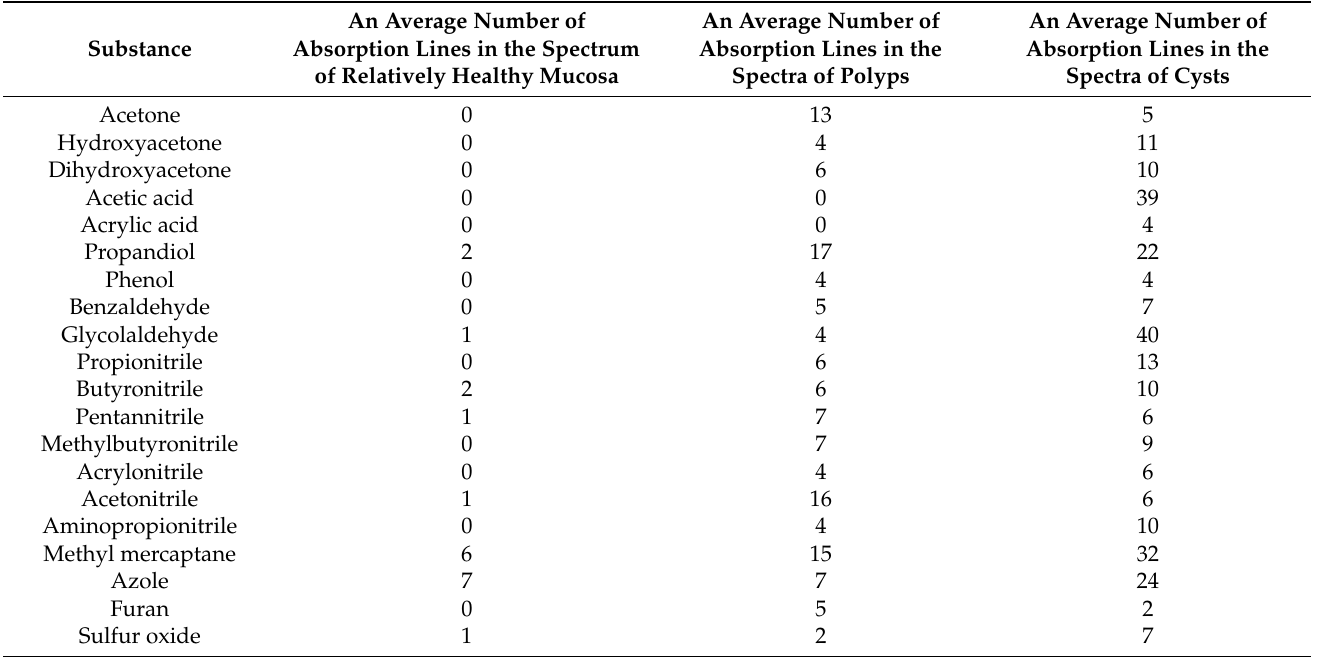
Table 1. The chemical composition of products of thermal decomposition and the average number of absorption lines for relatively healthy mucosa, polyps, and